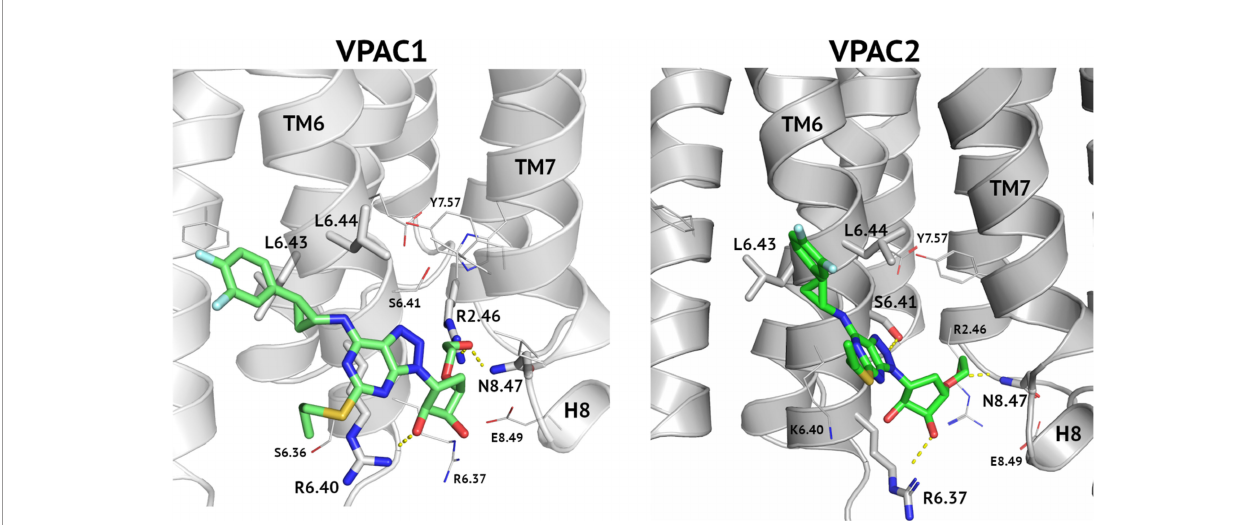
FIGURE 5 | An allosteric binding mode of ticagrelor to VPAC1 and VPAC2. A hydroxyethyl group interacts with Arg2.46 and Asn8.47 and thus blocks the receptor activation. A hydrogen bond between a hydroxyl group of a cyclopentyl group and Arg6.40 (VPAC1, left) or Arg6.37 (VPAC2, right) additionally stabilize the ligand position. A di fl uorophenyl group of ticagrelor is located between two adjacent leucine residues of